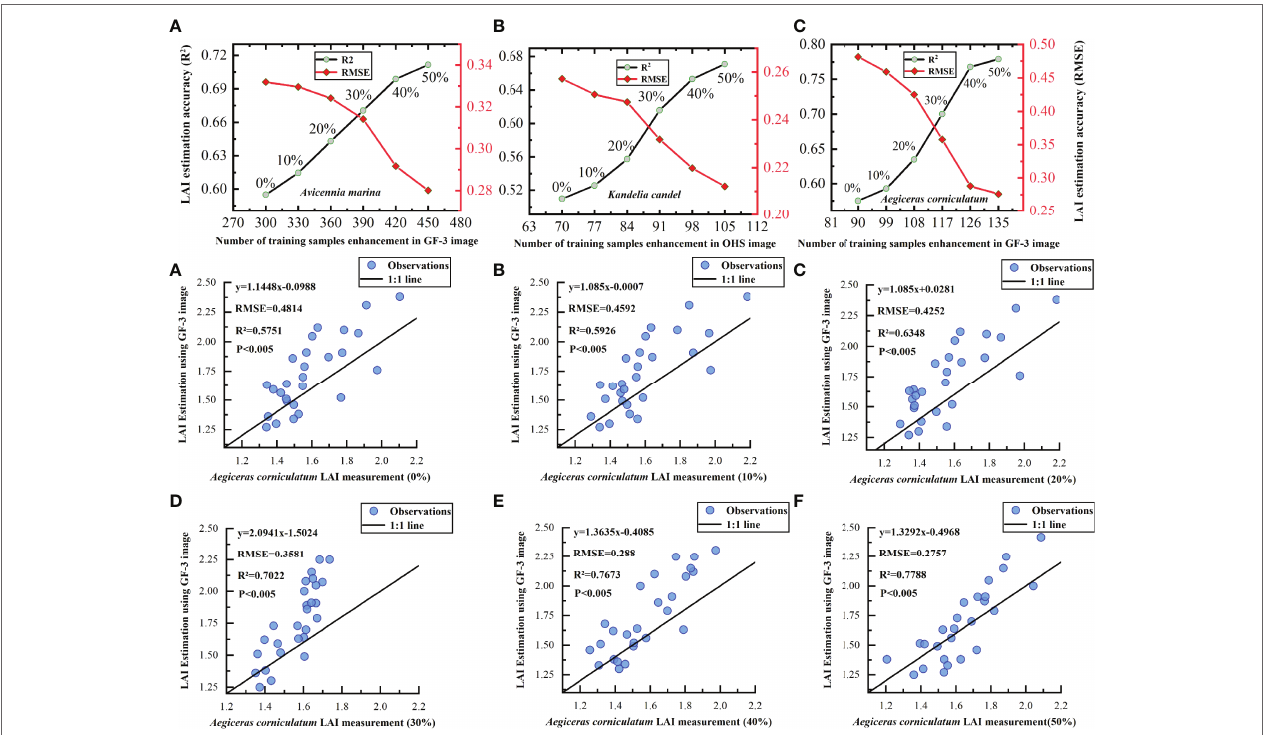
FIGURE 8 | Estimating mangrove LAI based on the DNN model under different sample expansion ratios. (A–C) Represents the variation trend of the estimation accuracy of the DNN model for the LAI of 'Avicennia marina', 'Kandelia candel' and 'Aegiceras corniculatum' under OHS and GF-3 image data with the enhancement of training sample data. (A–F) Indicates the variation trend of the estimation accuracy of the DNN model for the LAI of 'Aegiceras corniculatum' under the GF-3 image data, with the increase of the training sample expansion ratio